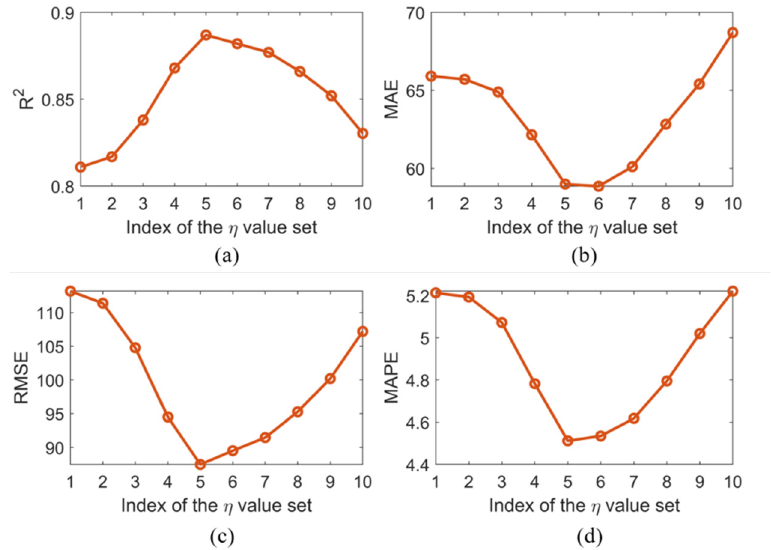
Figure 11. Sensitivity analysis on the regularization parameter, η . ( a ) R2. ( b ) MAE. ( c ) RMSE. ( d )